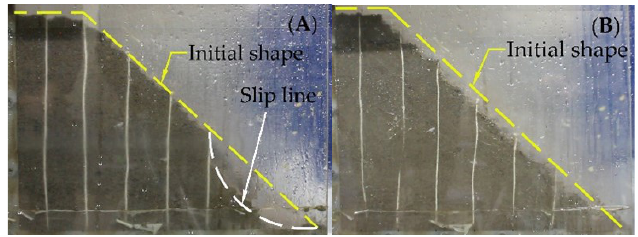
Figure 16. Rainfall-induced failure type of model embankments ( A ) K 8.5A ( B ) and K 40A .